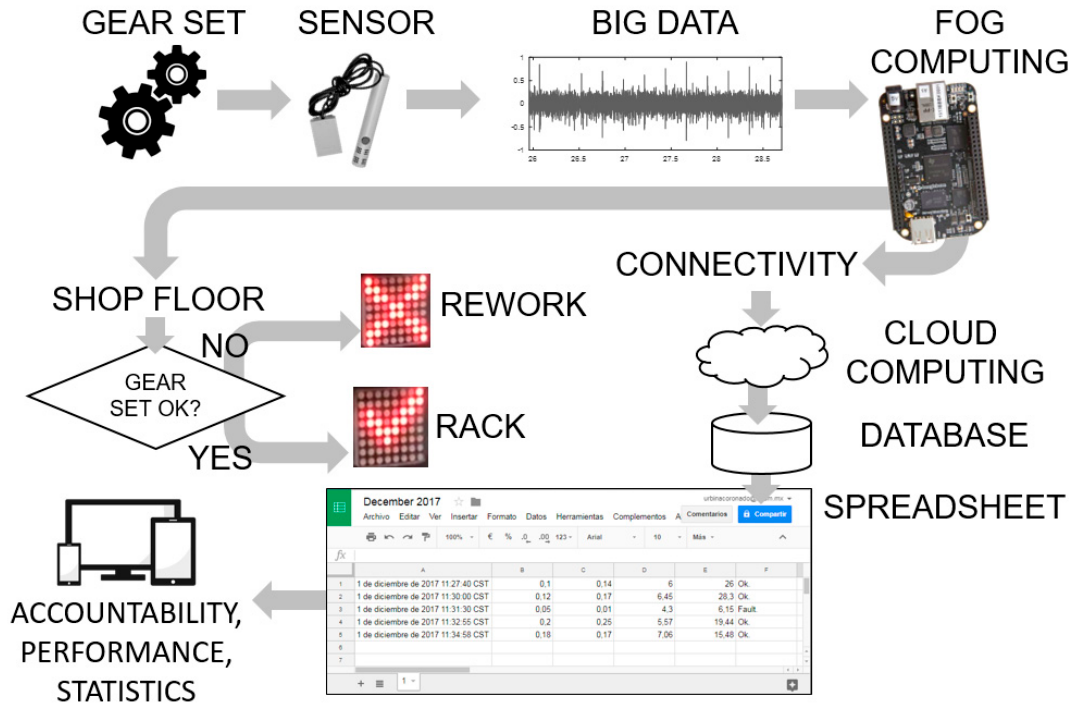
Figure 12. Diagram of the flow of information in the smart manufacturing gear set monitoring system.